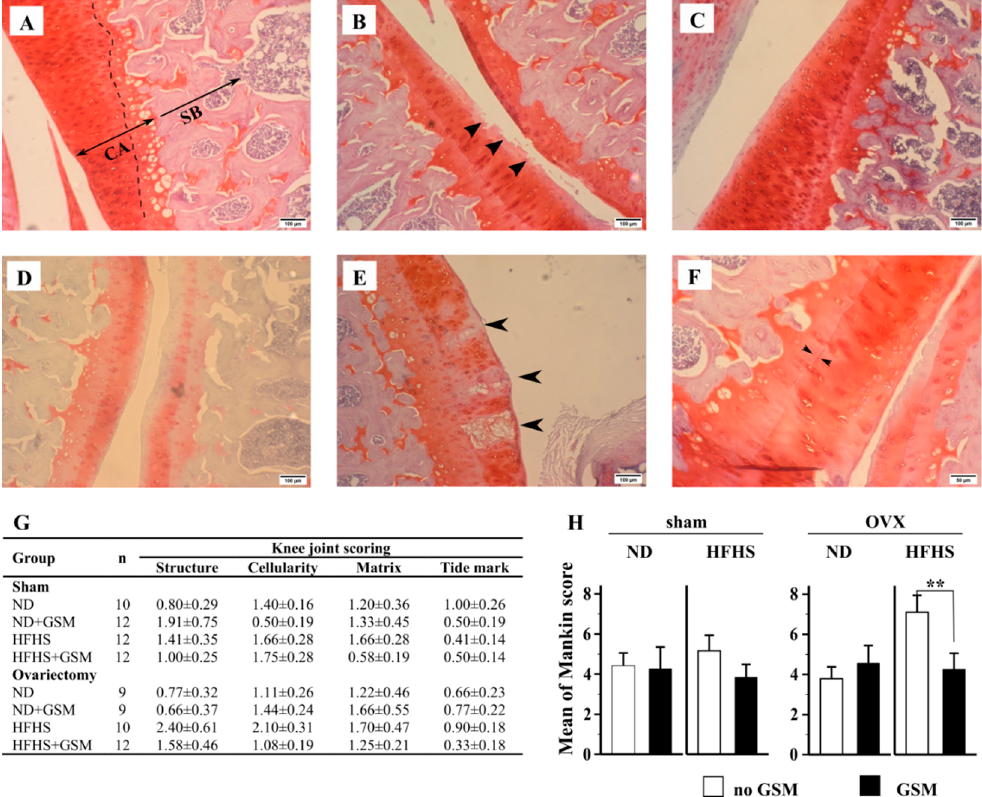
Figure 6. Pathological changes in rat’s knee joints at 48 weeks of age. Knee joints from rats at the end of the study were dissected, formalin-fixed, and decalcified prior to processing tissue slides. Slides were stained with Safranin-O showing in panels A–F. Panel ( A ) shows normal features of rat tibia bone as which articular cartilage is stained red (CA) and subchondral and trabecular bone are pink (SB). The cartilage can be divided by tide mark (dotted line) into two zones; non-calcified cartilage (from the surface area to tide mark junction) and calcified cartilage (under tidemark to subchondral bone plates). The abnormality of articular cartilage can be marked as surface irregularity (black arrows in panel ( B )), cloning and clusters of chondrocytes ( C ), pale staining of cartilage matrix ( D ), degeneration and necrosis of chondrocytes (black arrow in panel ( E )), and duplicated tide mark ( F ). Mankin score criteria were used to grade the severity of cartilage lesion in each group and mean ± SE is showed in the table ( G ). Finally, all criteria were summed and presented as a mean ± SE of Mankin score in the bar chart ( H ). Mann–Whitney U test was used to analyzed statistical differences between groups and asterisk ** shows significance at p < 0.01.